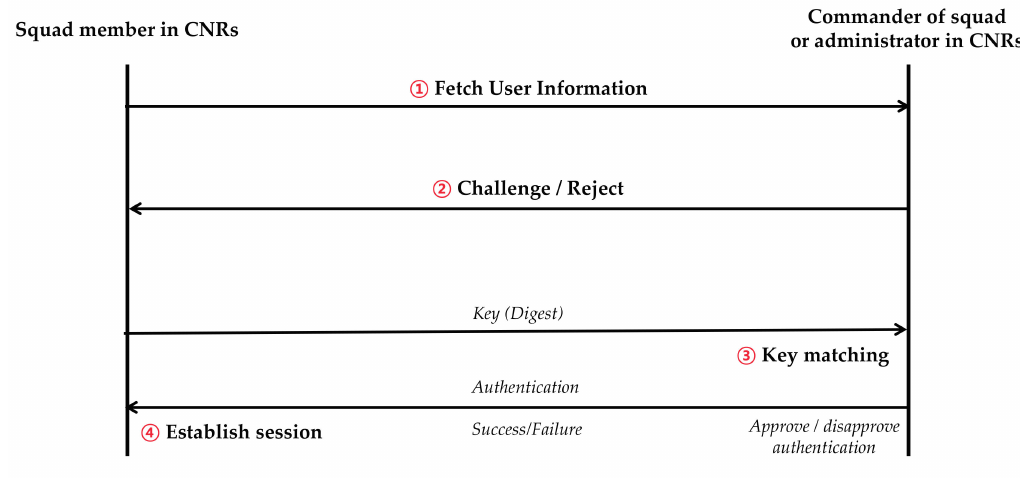
Figure 2. Initialization and registration